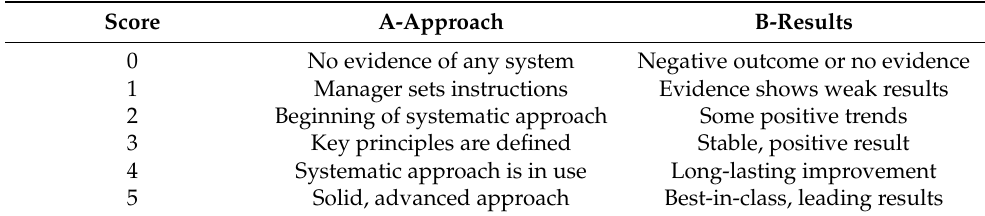
Table 2. Self-assessment criteria for Approach (A) and Results (B).